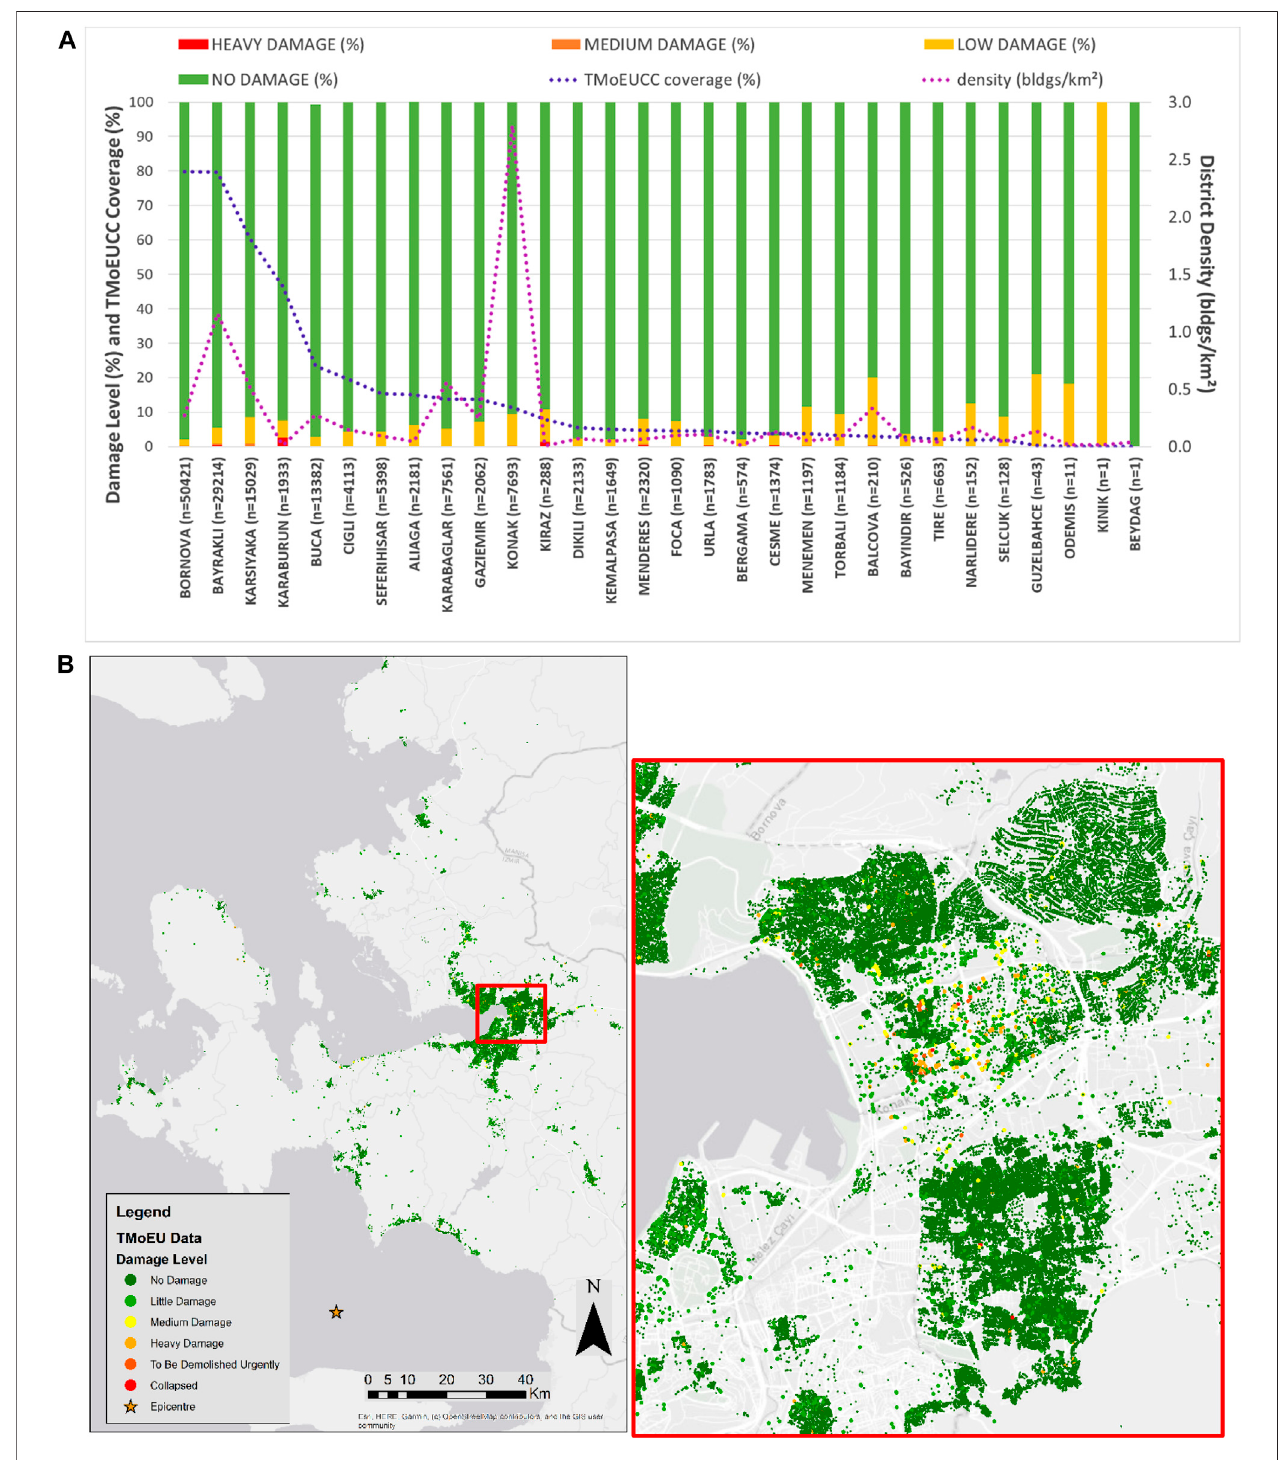
FIGURE 2 | (A) District-by-district damage assessment outcome and coverages by TMoEUCC as of end of November 2020. Please note that the damage categories reported here are the ministry ’ s own (B) Distribution of damage levels from the TMoEUCC database. The imageon the right shows the Bayrakl ı and Bornova area. All this information was used to delineate the mission itinerary to come up with a database complementary to TMoEUCC ’ s while minimising duplication.